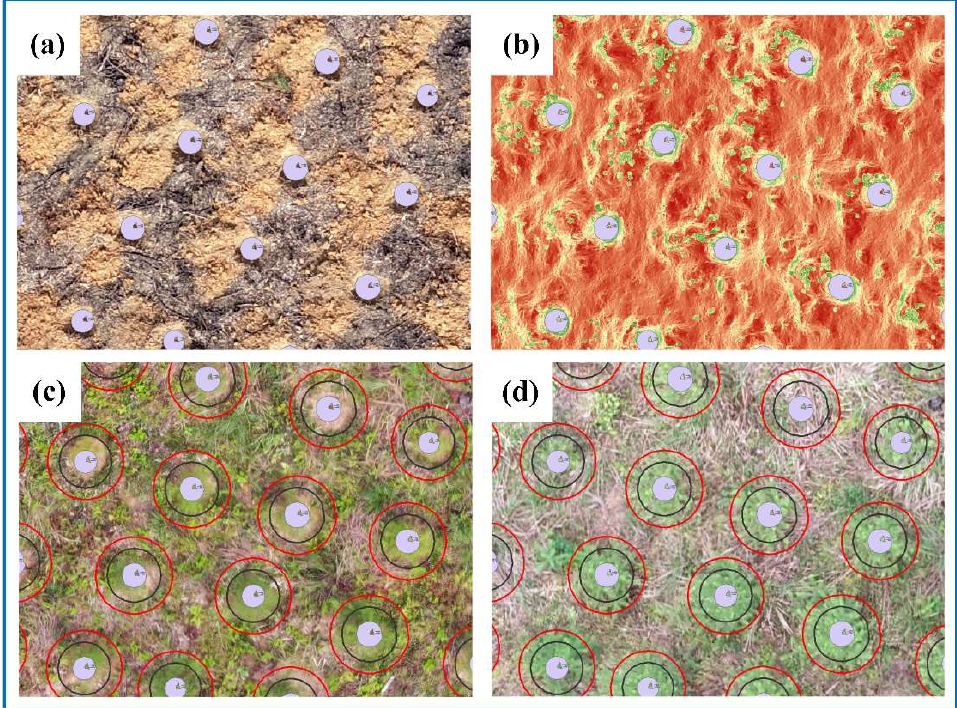
Figure 6. The location of tree pit and the determination of registration. ( a ) shows automatically obtained tree pits shapefile; ( b ) shows the result of manual correction; ( c ) shows optical UAV imaging in October, 2020; ( d ) shows optical UAV imaging in October 2021. The process of obtaining the location and size of tree pits, the red circle is the result of the 0.25 buffer and the black circle is the result of the 0.45 buffer.